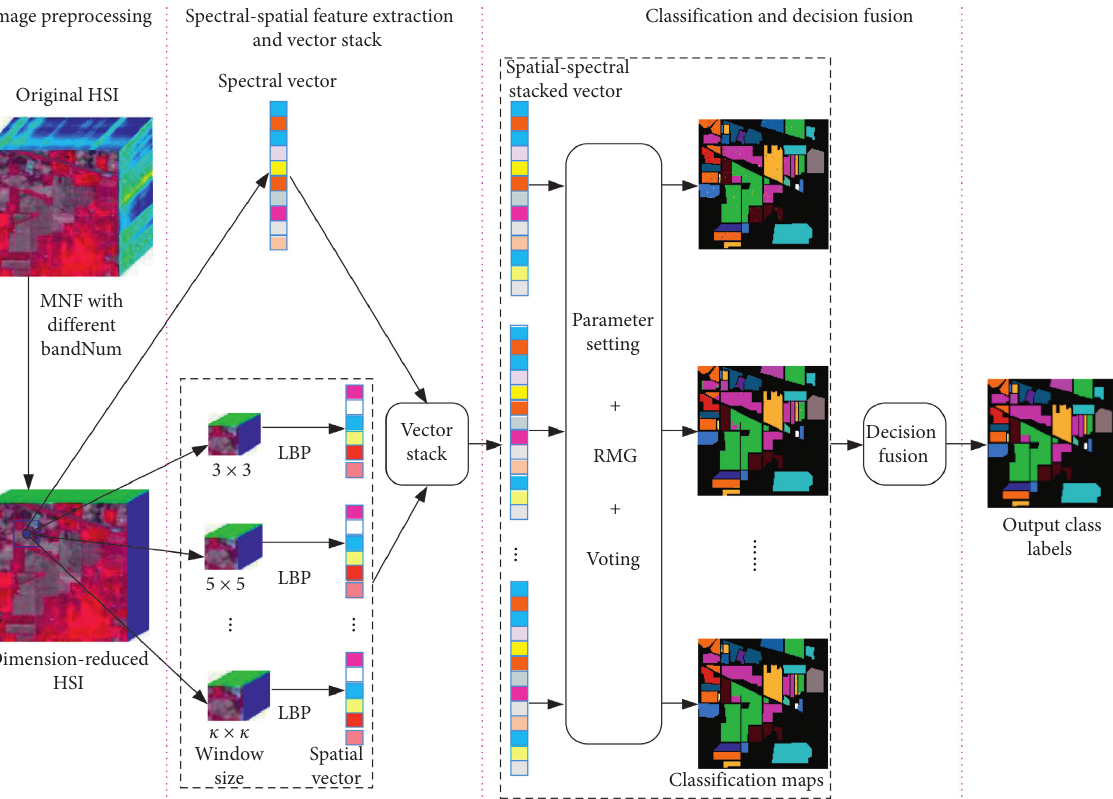
Figure 3: Schematic of the SS-MNF-ARMG